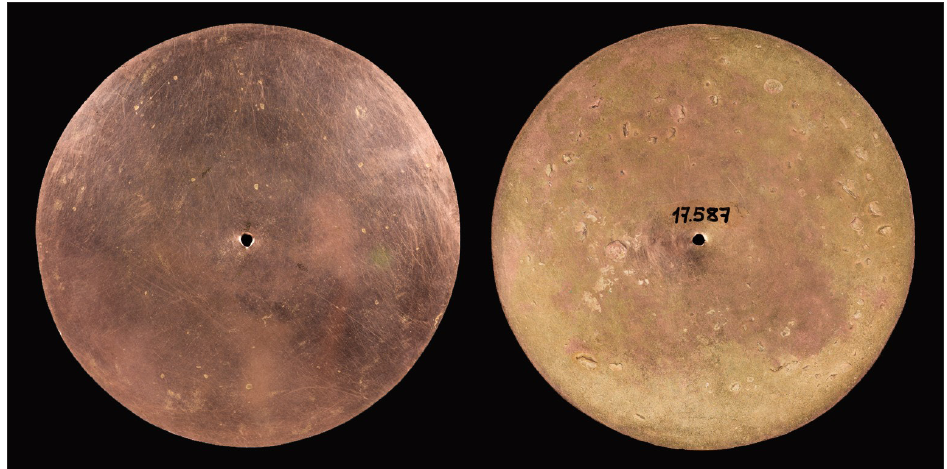
Figure 2: Front (left) and back of a Nahuange pectoral (O17587). The front has been polished intensively to remove the golden layer and expose the colour of the orange copper beneath. The back is unpolished and remains golden by depletion. Diameter is 10 cm (Photo